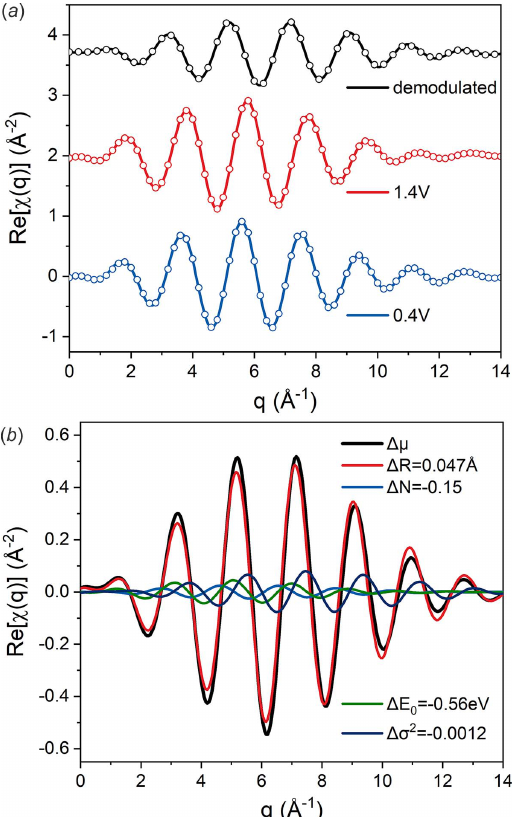
Figure 7 ( a ) Back Fourier transform ( R range 1.2–1.95 A˚ ) of the results of the combined fitting of the demodulated spectrum and original spectra. Circles: experimental data. Lines: fitted data. ( b ) The contributions of different changing parameters obtained from fitting.